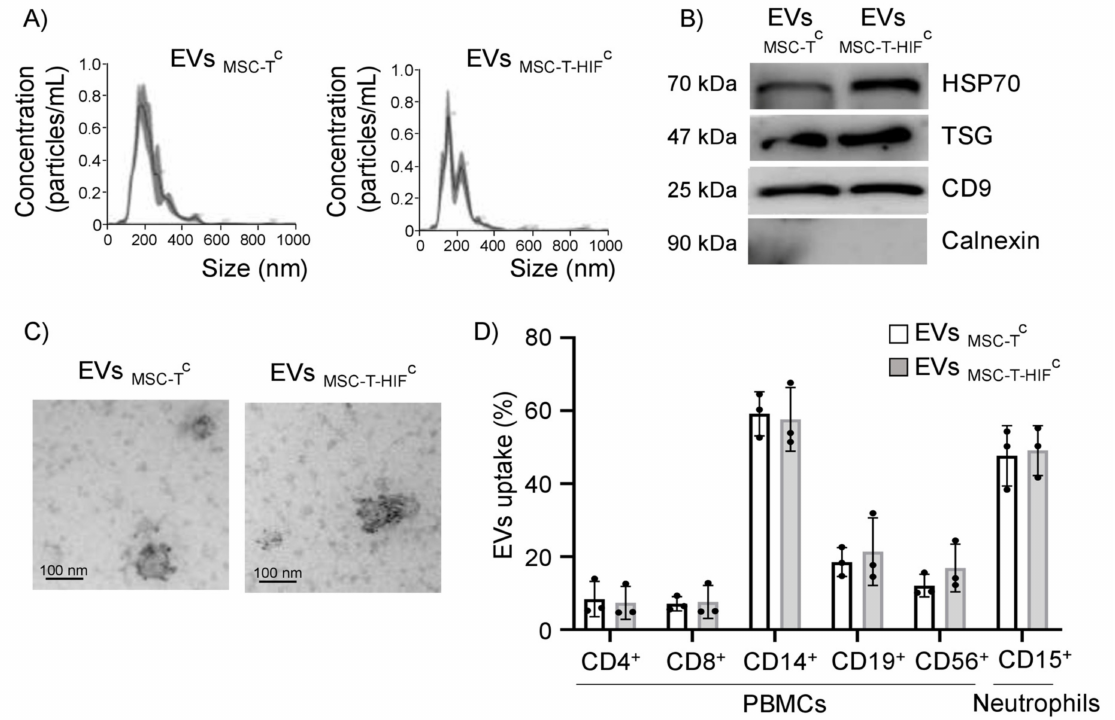
Figure 1. Characterization of MSC-EVs and their uptake by different leukocyte subpopulations. ( A ) Representative images of EVs assessed by nanoparticle tracking analysis; ( B ) representative Western blots of Hsp70, TSG101 and CD9 proteins in 30 µ g of loaded of EVs; absence of calnexin signifies a pure EV preparation; ( C ) representative transmission electron microscopy images of isolated EVs. Scale bar: 100 nm. EVs showed positive immunogold-labeling of the transmembrane extracellular protein CD63, a canonical EV marker. ( D ) Peripheral blood mononuclear cells and neutrophils were incubated with carboxyfluorescein succinimidyl ester (CFSE)-labeled EVs for 3 h at 37 ◦ C and EV internalization was assessed by flow cytometry. As a negative control, PBS was mixed with CFSE and added to immune cells in parallel. Cell types were analyzed by specific surface markers for T-cells (CD4 + and CD8 + ), B-cells (CD19 + ), monocytes (CD14 + ), natural killer cells (CD56 + ) and neutrophils (CD15 + ). EV internalization was measured by fluorescence intensity and is represented as the percentage of EVs internalized by each cell population. Graphs represent mean ± SD of three independent